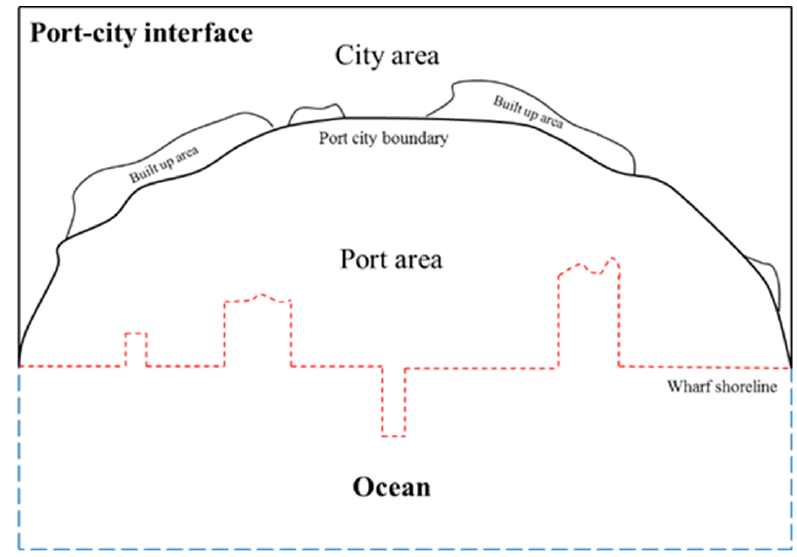
Figure 2. Schematic diagram of port-city interface (source: drawn by author).